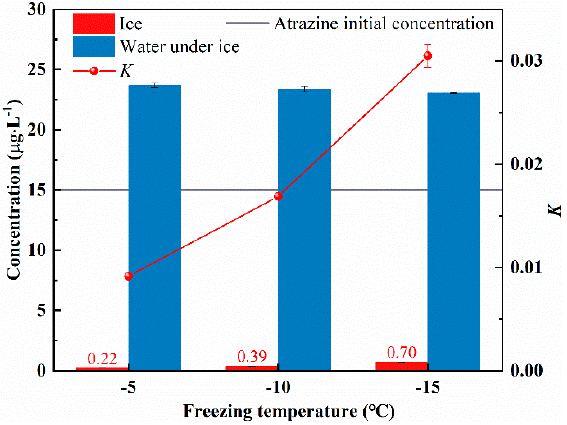
Figure 3. Ice-water distribution of atrazine at different freezing temperatures.